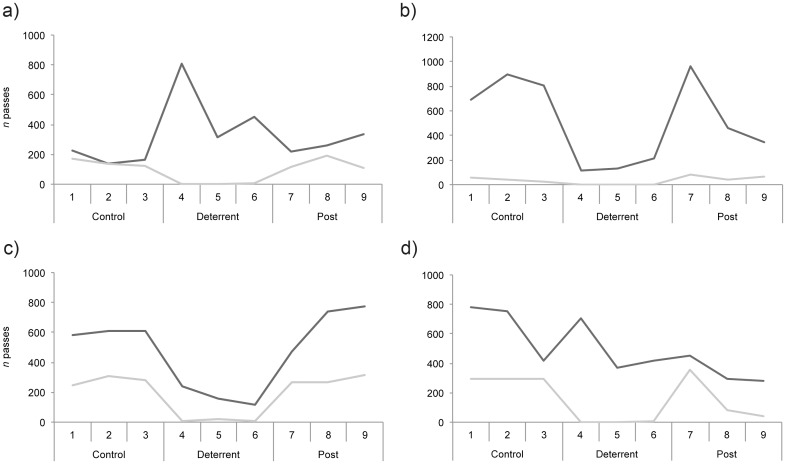
Activity of Myotis nattereri in lit and unlit areas of churches during lighting deterrence experiments.The figure shows the number of bat passes recorded each night for two hours after sunset using infrared video in lit (light grey lines) and unlit (dark grey lines) zones inside churches during control (ambient light), deterrent (artificial light) and post-deterrent (ambient light) periods at four churches: (a) Cley, (b) Great Hockham, (c) Holme Hale and (d) Salle.